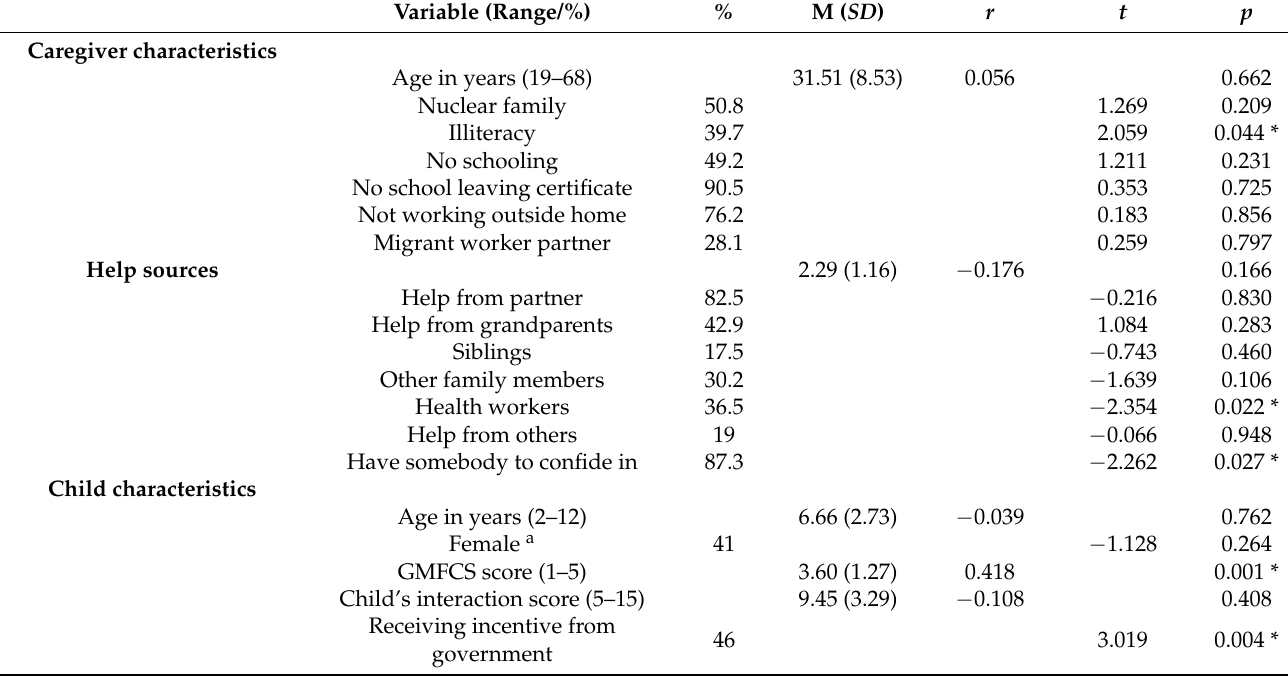
Table 1. Caregiver and child characteristics and relationship to the General Health Questionnaire-12 (GHQ-12). Variable (Range/%) % M ( SD ) r